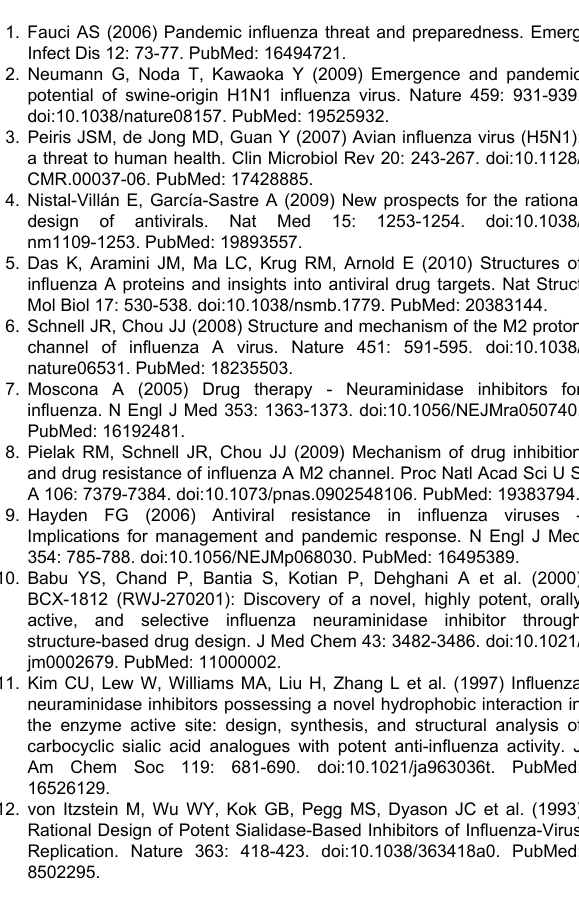
Figure S1. Distance between ETT and the active site of 09N1. The minimum distance between R371 and carboxyl group of ETT is shown in black. The minimal distance between D151 and ETT is shown in red.